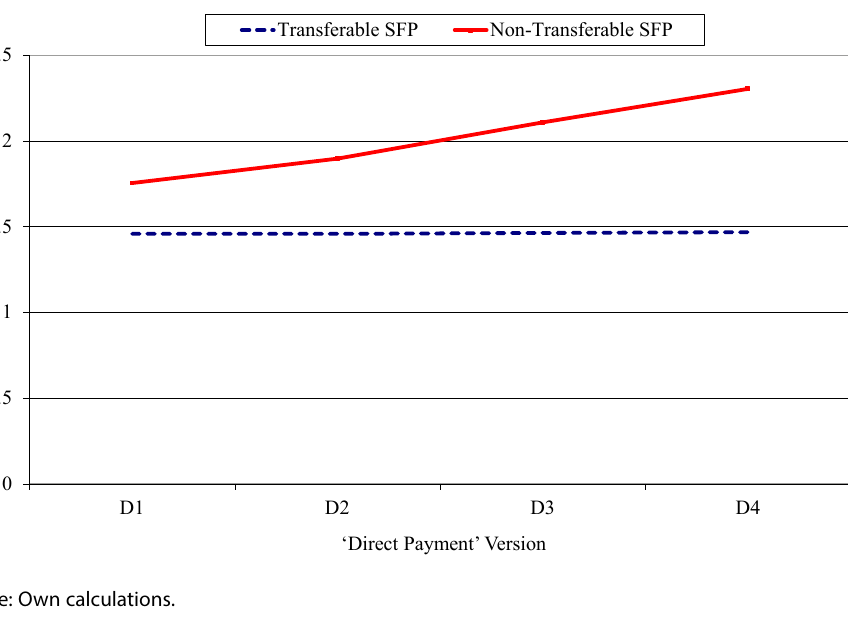
Figure 8. Average farm-exit rates for the whole of Switzerland in the transferable and non-transferable SFP